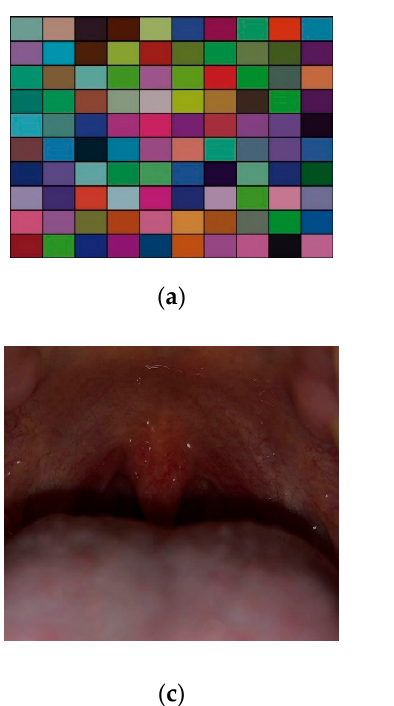
Figure 4. Comparison of R, G, and B values among reference, iPhone X, and color-corrected patches. Here, 10 color chart patches are chosen from 100 patches. ( a ) Red channel values, ( b ) green channel values, and ( c ) blue channel values.